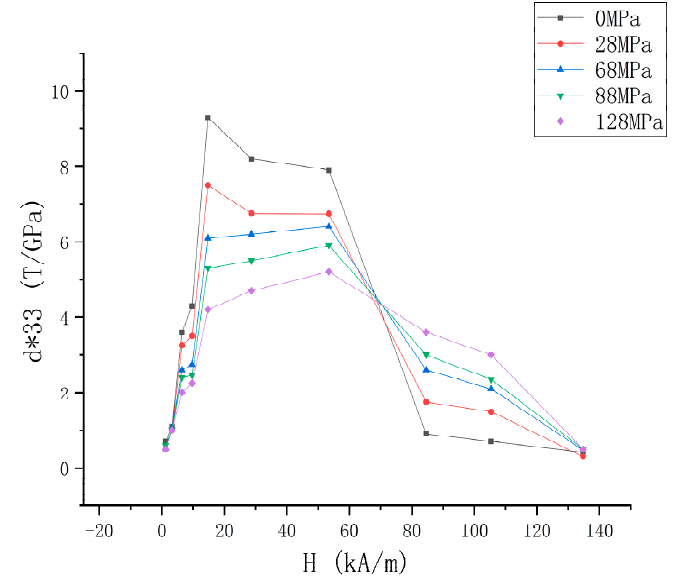
Figure 6. Relationship between piezomagnetic coefficient and bias magnetic field under different compressive stress.